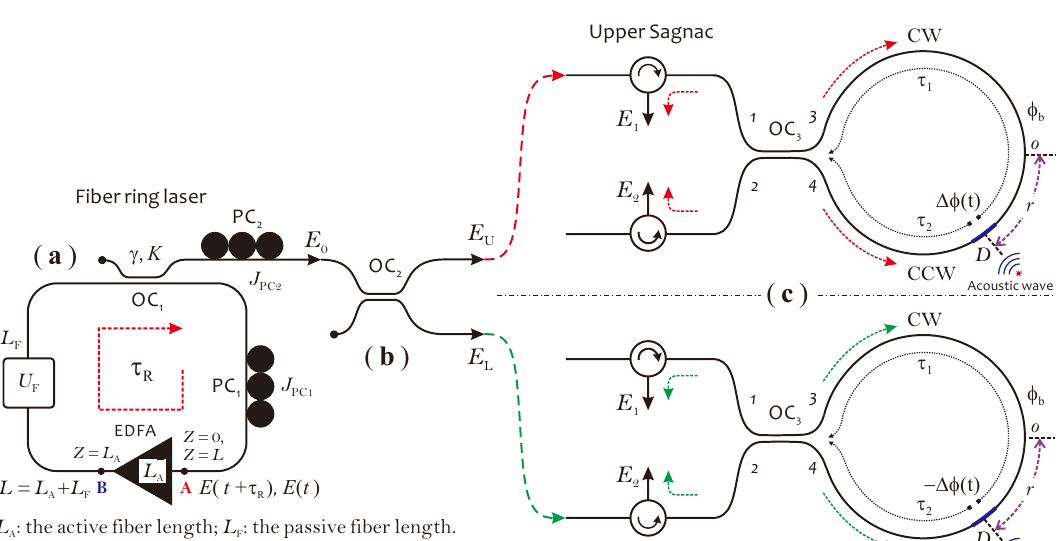
Figure 5. Theoretical models used to describe the principles: ( a ) for a chaotic fiber ring laser; ( b , c ) for a balanced Sagnac sensor. CW, clock-wise; CCW, counter